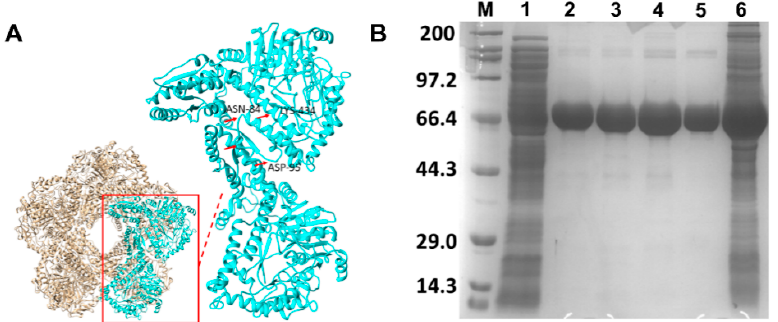
Figure 2. Protein structure and expression. ( A ). The modeled structure of SmcadA, showing the complete decamer and inset, indicates the dimer units with the main residues involved in cofactor PLP binding. ( B ). 12% SDS page image of the expressed proteins. M represented the Protein Marker-Broad (Takara, China); 1 is the E. coli. BL21 control strain. 2–5 showed the 75 kDa purified SmcadA. 6 is the unpurified SmcadA.Table 1. This is a table. Tables should be placed in the main text near to the first time they are cited.